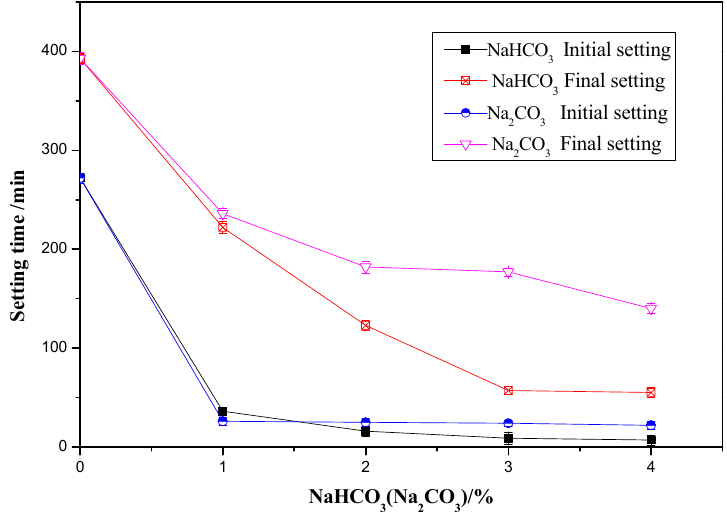
Figure 1. Effects of NaHCO 3 and Na 2 CO 3 on the setting time of OPC paste.